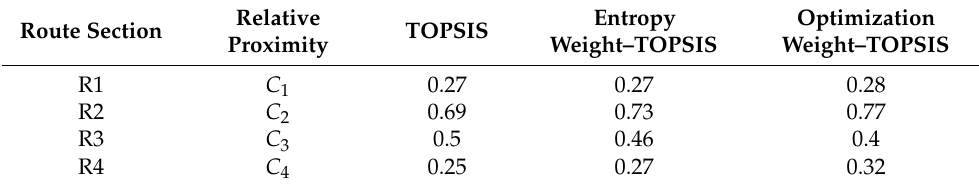
Table 8. Relative proximity of three methods.